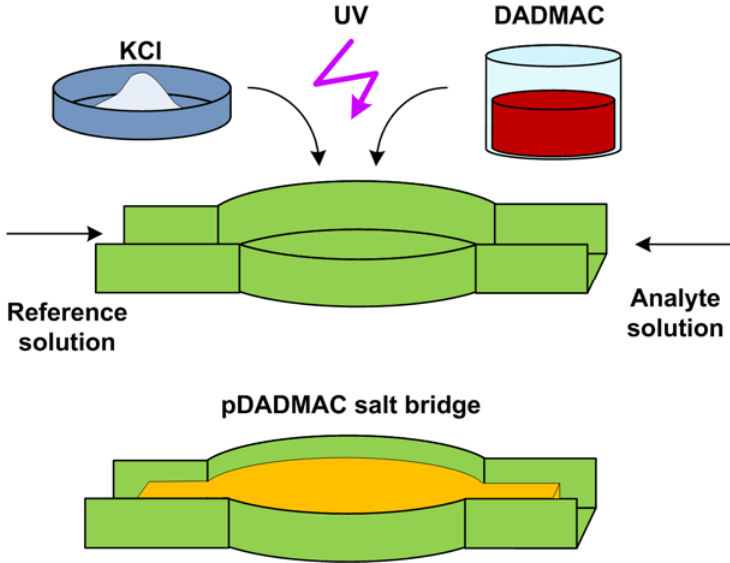
Figure 10. UV polymerization and chloride trapping in a salt bridge